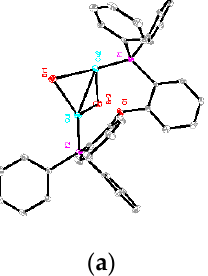
Figure 1. Single crystal structure of CuPBr ( a ), its Hirshfeld surface plotting ( b ) and its packing mode ( c ).